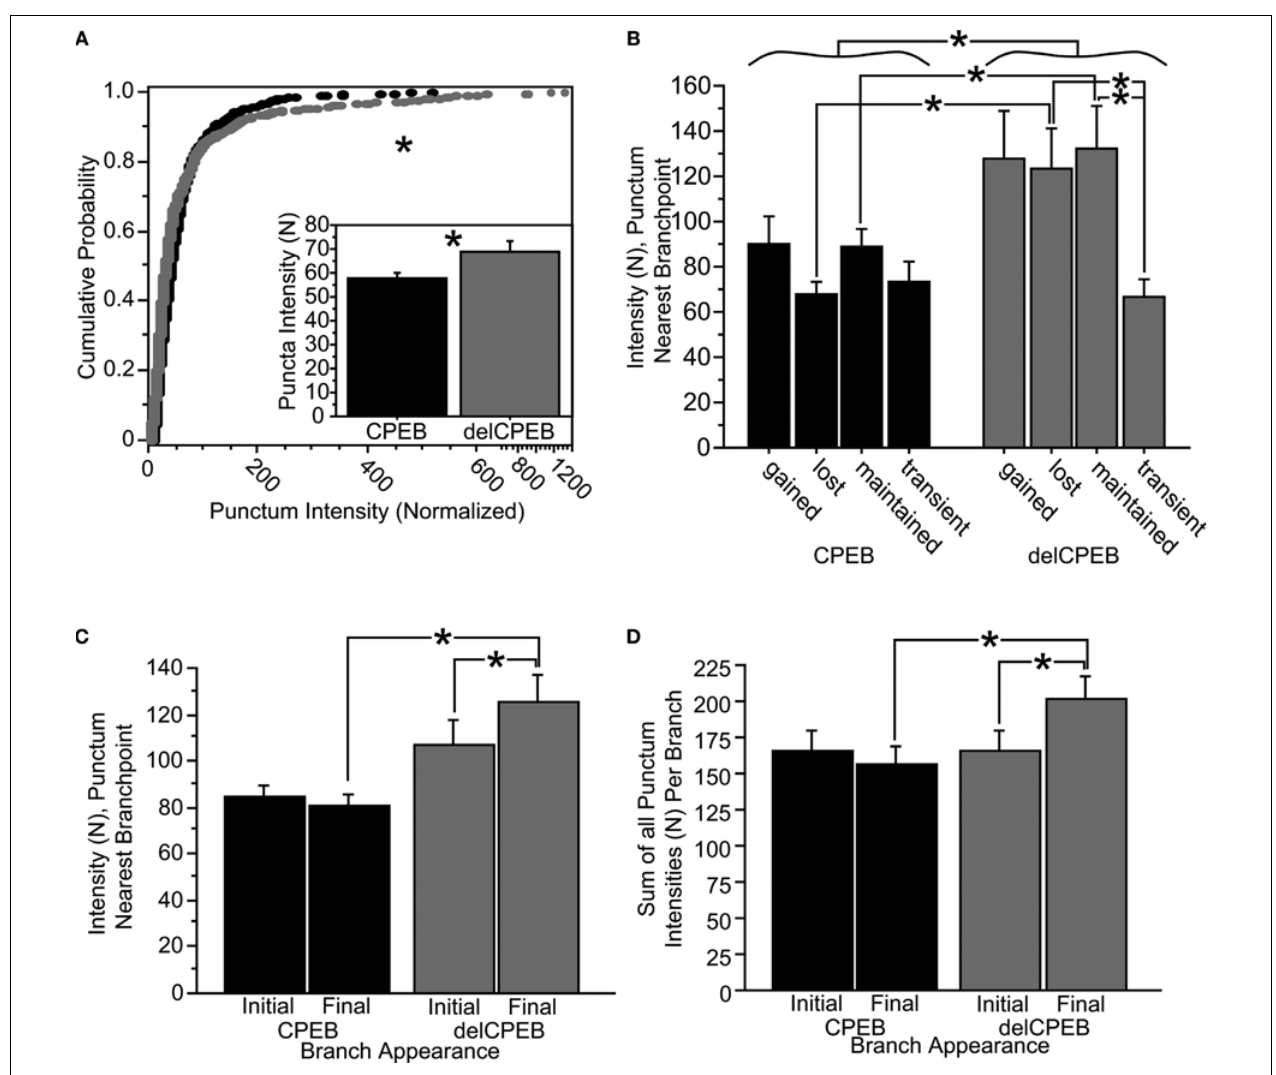
FIGURE 8 | delCPEB puncta have greater fl uorescence intensity values than CPEB puncta. (A) The distributions of intensities of the puncta from delCPEB- expressing neurons, or the mean puncta intensity (inset) are signifi cantly higher than those of the CPEB-expressing cells (Kolmogorov–Smirnov test, p < 0.0001 and unpaired t -test, p = 0.04). (B) Together, the delCPEB-expressing cells have a higher fl uorescence intensity of the puncta nearest the branch points than CPEB-expressing cells (unpaired t -test, p = 0.002). The lost and maintained delCPEB-expressing neuronal branches have higher branch point puncta